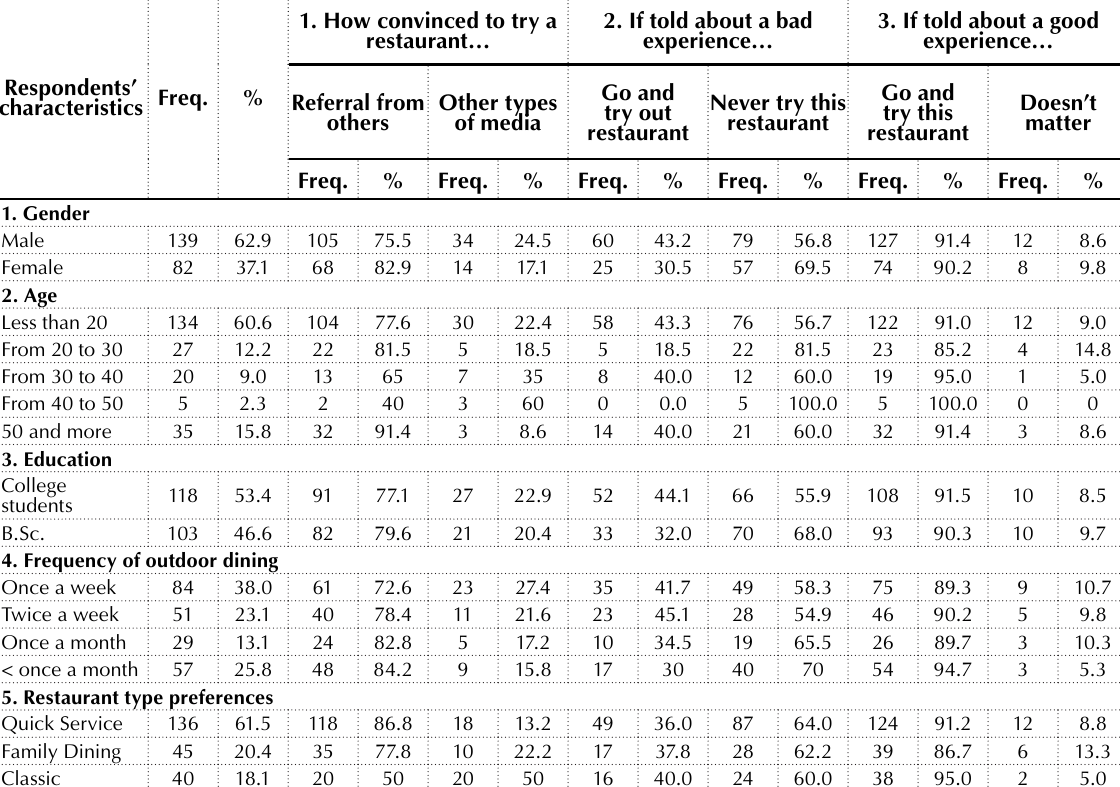
Table 2. Associating WOM-related behaviors to consumers’ characteristics